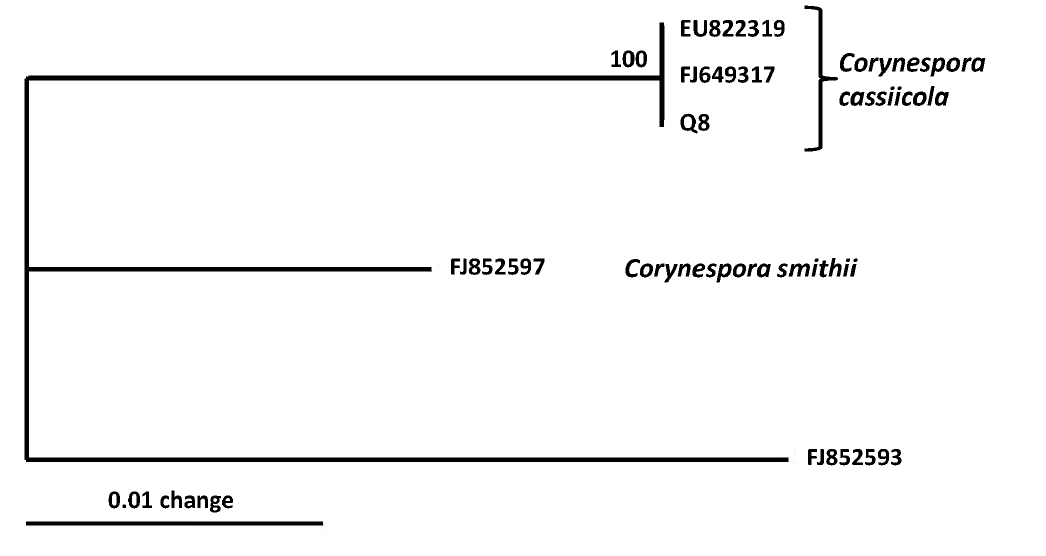
Figure 1. Phylogram representing the relationship of Corynespora cassiicola isolate from Oman (Q8) to sequences of Co. cassiicola and two other Corynespora species based on the ITS rDNA sequences. Numbers within the tree rep- resent the bootstrap values (values above 50% are indicated; 1000 replications). The tree was rooted to Co. citricola